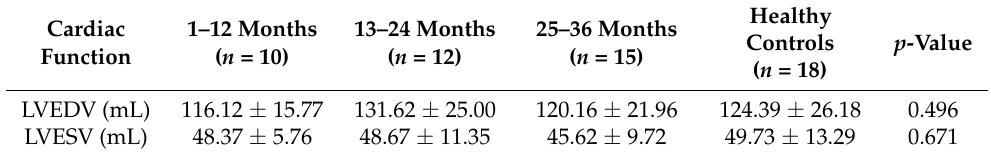
Table 4. Subgroup analysis based on disease duration.